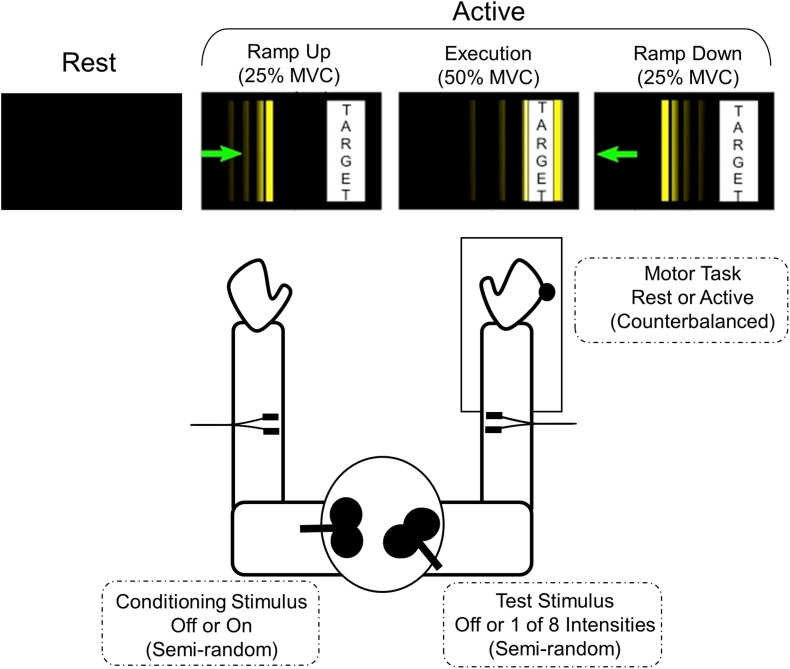
Motor task and experimental set-up. The participant is seated with their shoulders in approximately neutral flexion, 20° abduction, and elbows at approximately 90° flexion. The forearm and wrist are in neutral position bilaterally. The right arm is placed in a custom arm rest with soft restraints with the dorsum of the hand positioned against a force transducer connected to a six-degrees-of-freedom load cell. The visual display for each active phase is depicted. The thin vertical line is the cursor that subjects moved by applying isometric wrist extension force to the joystick. The goal is to move the cursor smoothly toward the target bar, hold within the target bar for at least 1.5 s, and make a controlled relaxation back to rest. The width and position of the target bar are scaled according to the participant’s maximum voluntary contraction (MVC).